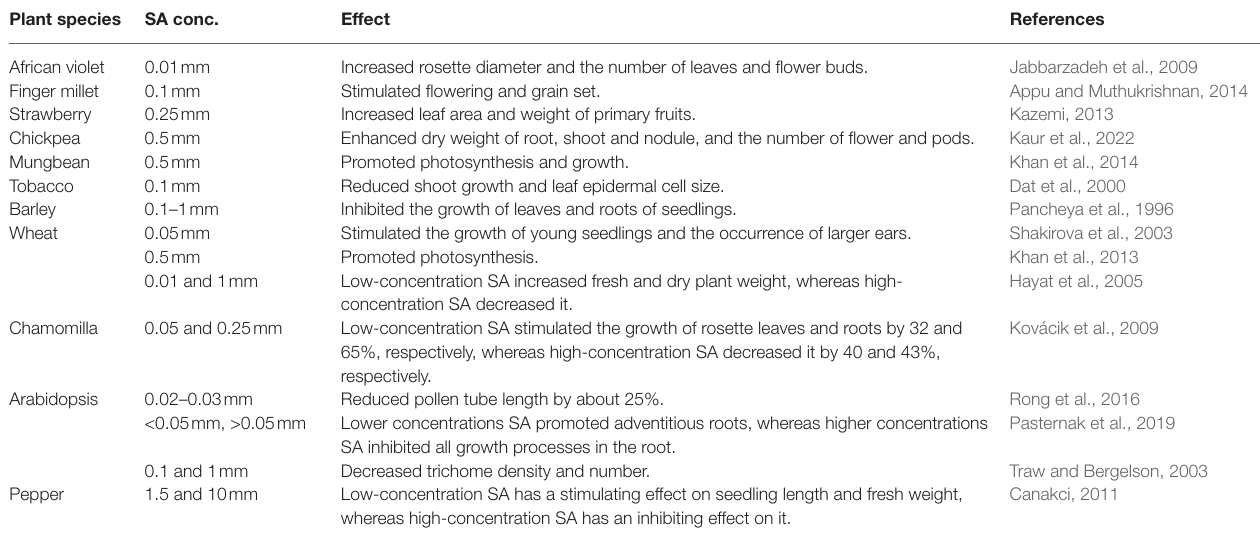
TABLE 1 | Effect of exogenous SA on growth in different plant species. Plant species SA